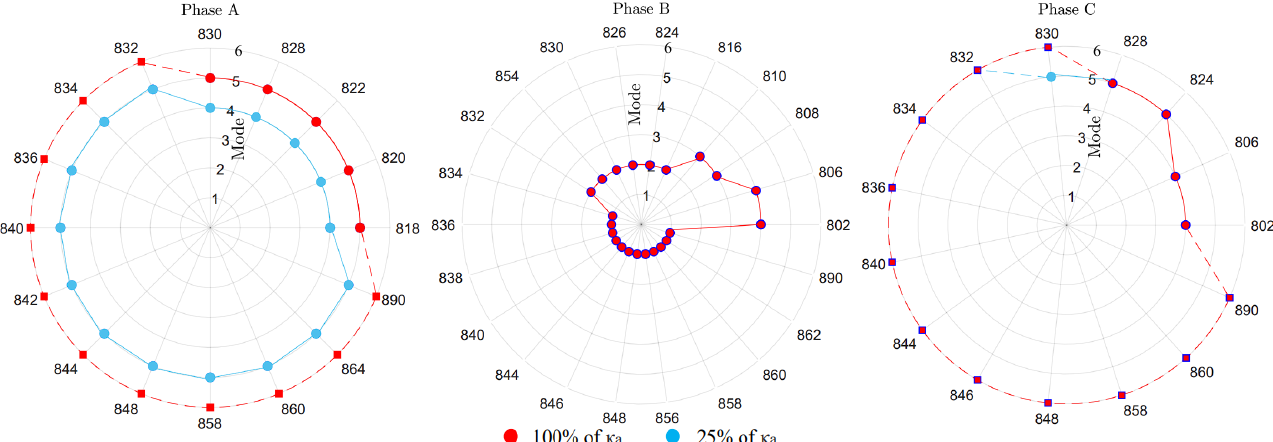
Figure 13. Operation modes using the proposed method for single-phase fault in phase B.